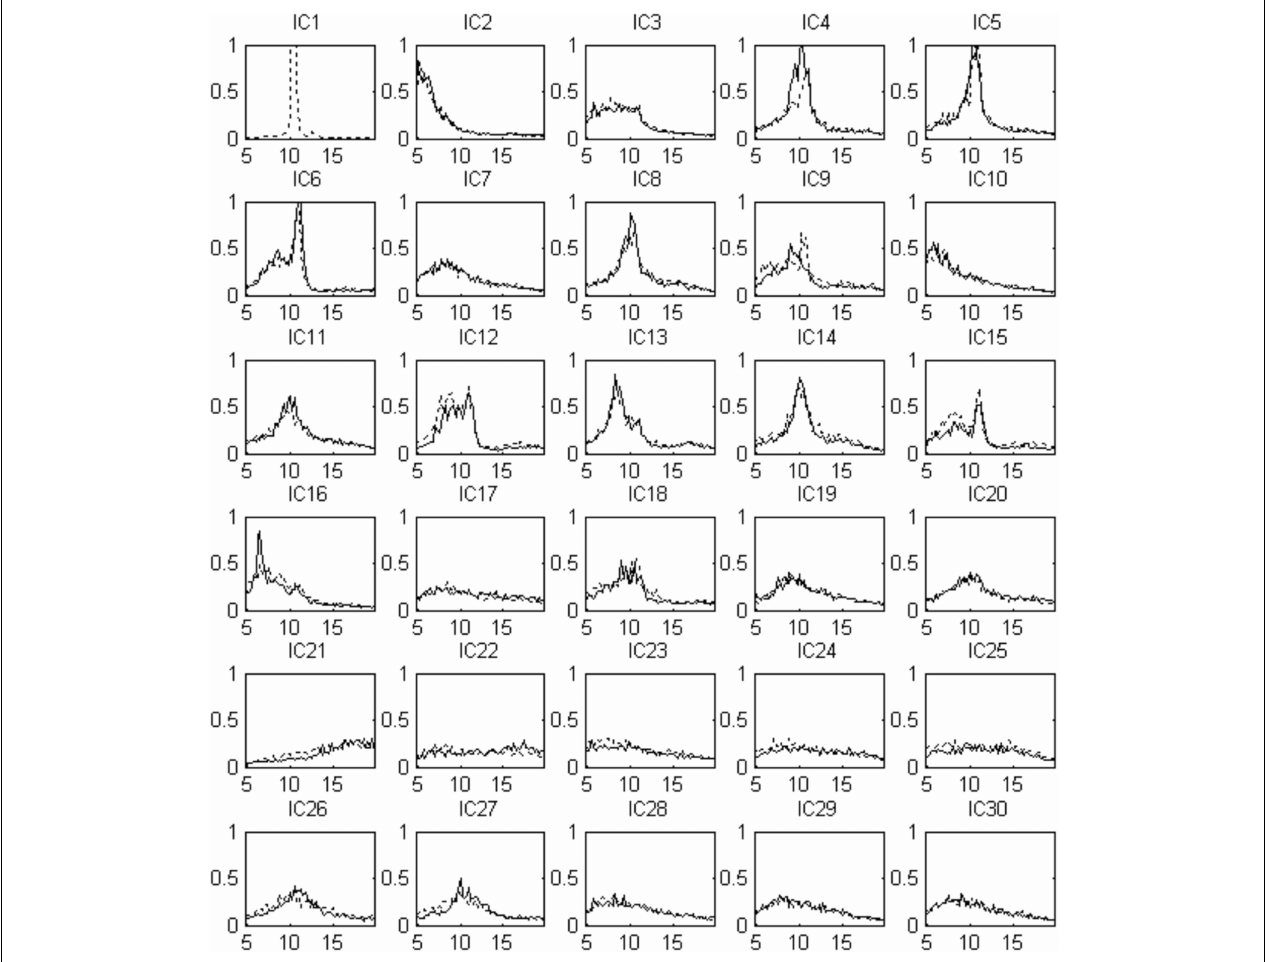
FIGURE 2 | Source signal power spectra curve corresponding to Figure 1: x-coordinate for frequency (Hz), y-coordinate for power spectrum ( u V 2 ). The solid line indicates pre-learning, the dotted line indicates